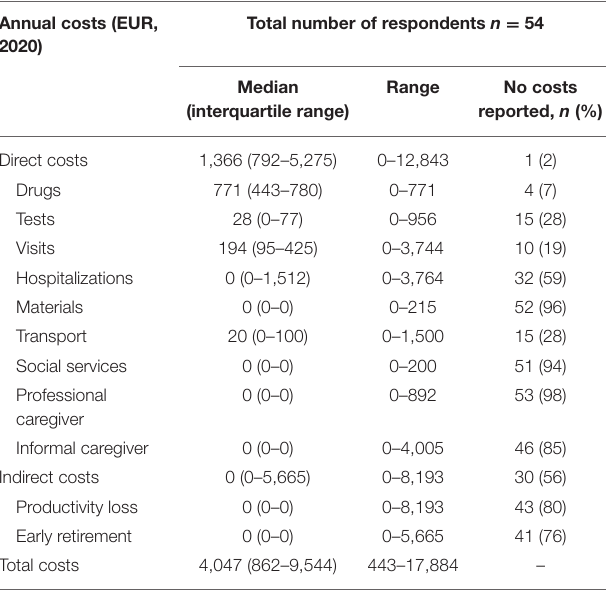
TABLE 2 | Clinical profile of the respondents. TABLE 3 | Socio-economic burden of MG in Bulgarian adult